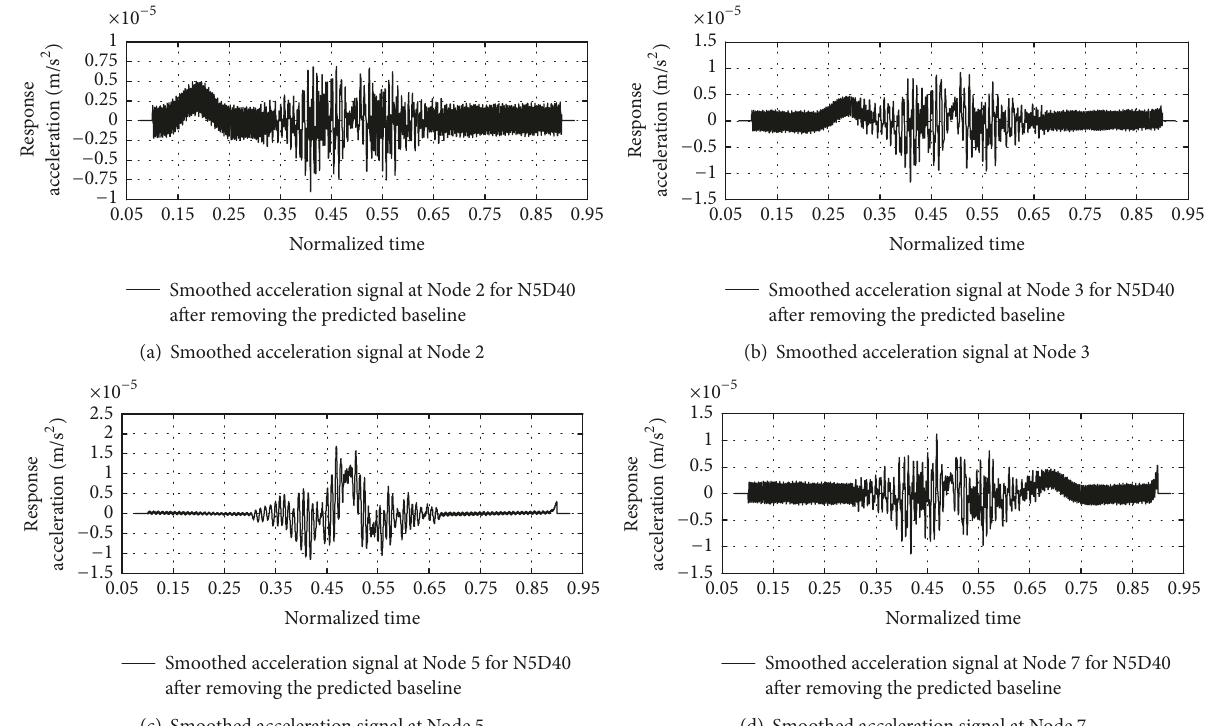
Figure 11: The smoothed acceleration signals after removing the predicted baseline (the damage occurred in the middle of the beam) at different locations: (a) signal from Node 2, (b) signal from Node 3, (c) signal from Node 5, and (d) signal from Node